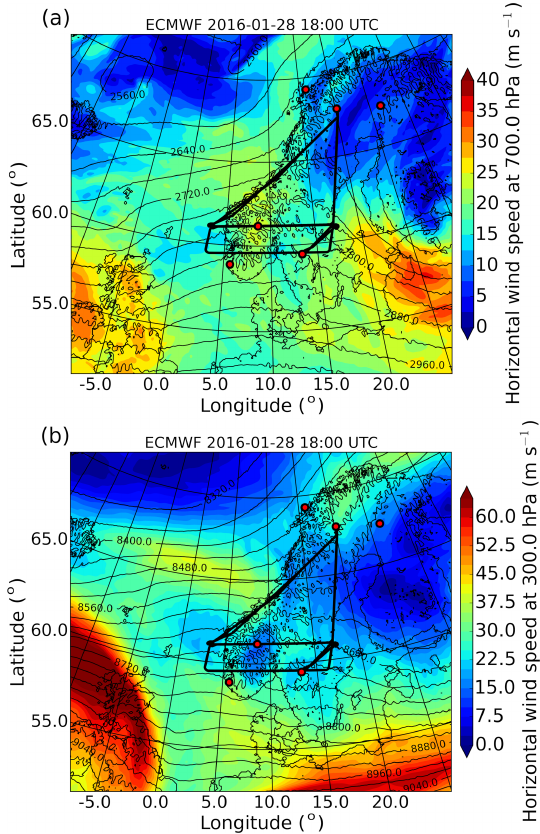
Figure 2. Meteorological maps of horizontal wind speed and geopotential height (black contour lines) at (a) 700hPa and (b) 300hPa at 18:00UTC on 28 January 2016 obtained from the ECMWF model. Black lines indicate flight legs of the three research flights and red dots mark the same locations as in Fig. 1.